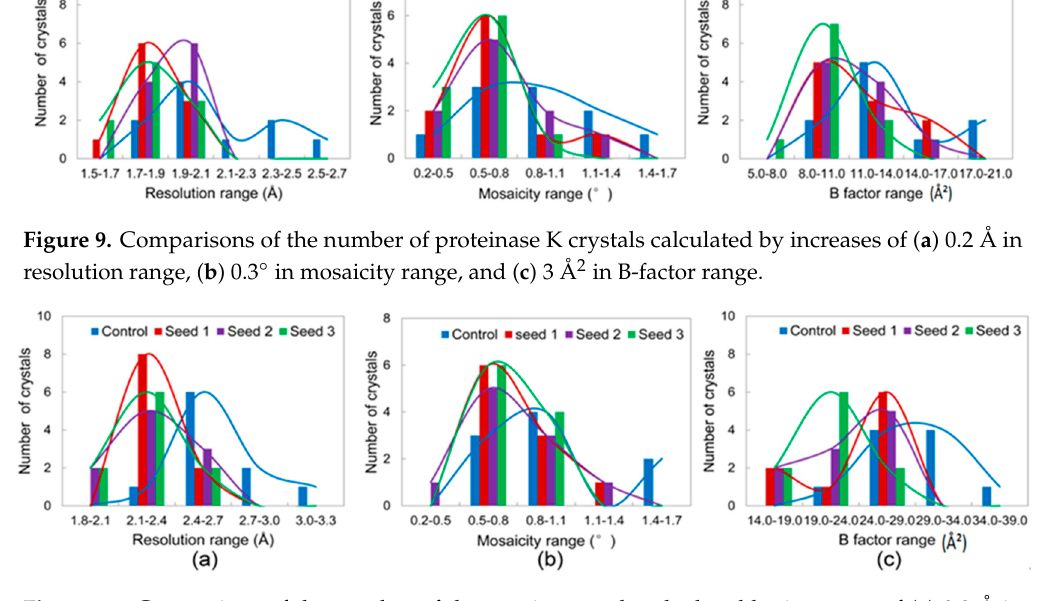
Figure 10. Comparison of the number of thaumatin crystals calculated by increases of ( a ) 0.3 Å in resolution range, ( b ) 0.3° in mosaicity range, and ( c ) 5 Å² in B-factor range.